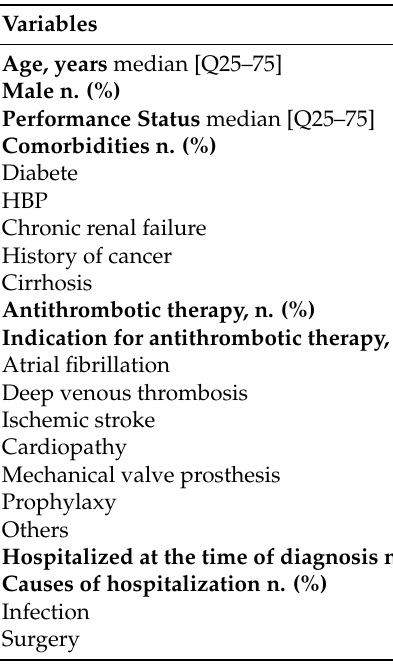
Table 1. Patient